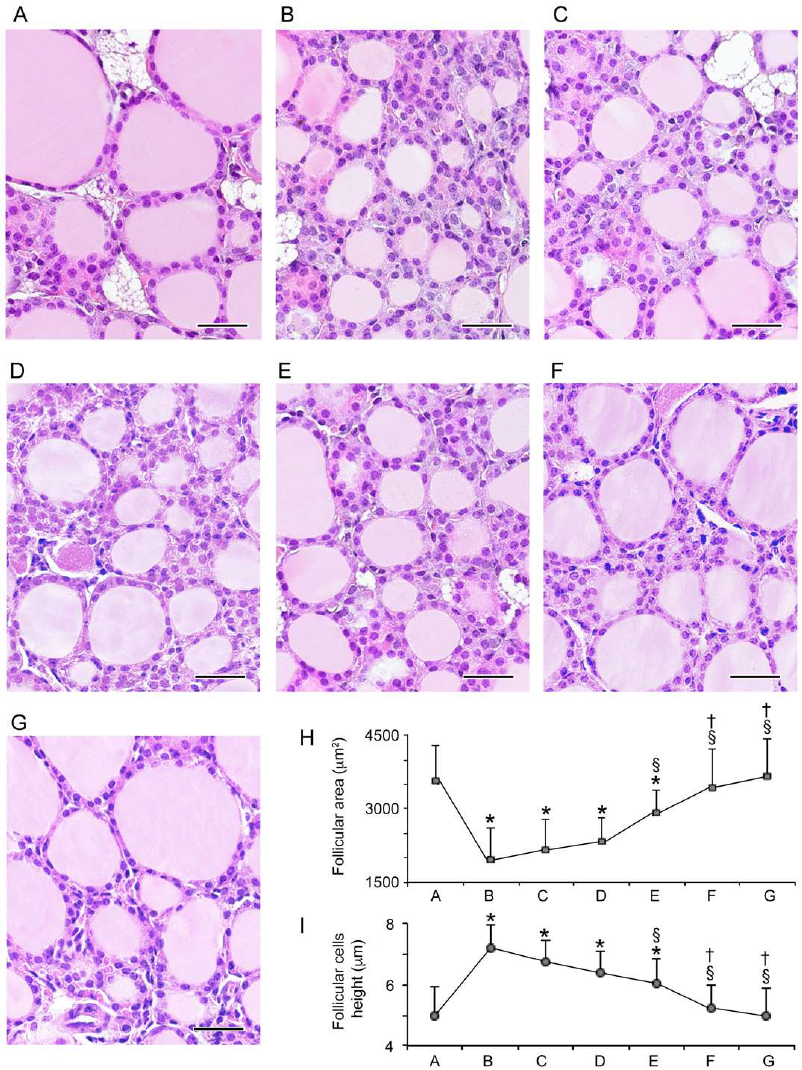
Figure 1. Histological organization of the thyroid (hematoxylin–eosin stain; scale bar: 25 µ m). Mice groups (seven mice / group) are: controls ( A ), cadmium chloride (CdCl 2 ) plus vehicle ( B ), CdCl 2 plus seleno-L-methionine (Se) 0.2 mg / kg ( C ), CdCl 2 plus Se 0.4 mg / kg ( D ), CdCl 2 plus myo-inositol (MI) ( E ), CdCl 2 plus MI plus Se 0.2 mg / kg ( F ), CdCl 2 plus MI plus Se 0.4 mg / kg ( G ). A: Control mice have a normal thyroid structure, as demonstrated also by bar A in H and I. B: CdCl 2 -treated mice show small follicles and less stainable follicular epithelium (thyrocytes), the height of which is increased, as shown by bar B in ( H , I ). C-D: In mice treated with CdCl 2 plus 0.2 mg / Kg Se or CdCl 2 plus 0.4 mg / kg Se, small follicles are present with thyrocytes of smaller height, as indicated by bars C and D in H and I. E: In mice treated with CdCl 2 plus MI, the follicles and thyrocytes show a tendency to acquire a normal size and height, even though both indices are significantly di ff erent from the controls; see also bar E in H and I. F-G: In mice treated with CdCl 2 plus MI and 0.2 mg / Kg Se or CdCl 2 plus MI and 0.4 mg / kg Se, follicles and epithelial cells were close to normal, as demonstrated by bars F and G in H and I. H: Mean ± standard error values of follicular area in the di ff erent groups of mice. I: Mean ± standard error values of epithelial cells height in the di ff erent groups of mice. * p < 0.05 versus control; § p < 0.05 versus CdCl 2 plus vehicle and CdCl 2 plus 0.2 or 0.4 mg / kg Se; † p < 0.05 versus CdCl 2 plus MI